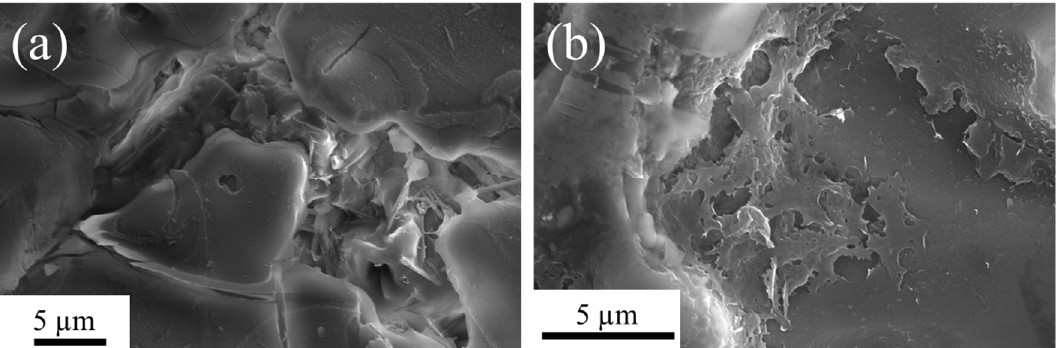
Figure 16. SEM micrographs of anodized samples after electrochemical corrosion testing in 5 wt.% NaCl solution: ( a ) 4-N sample-anodized sealed with NiF 2 and ( b ) 4-S sample-anodized sealed with stearic acid.